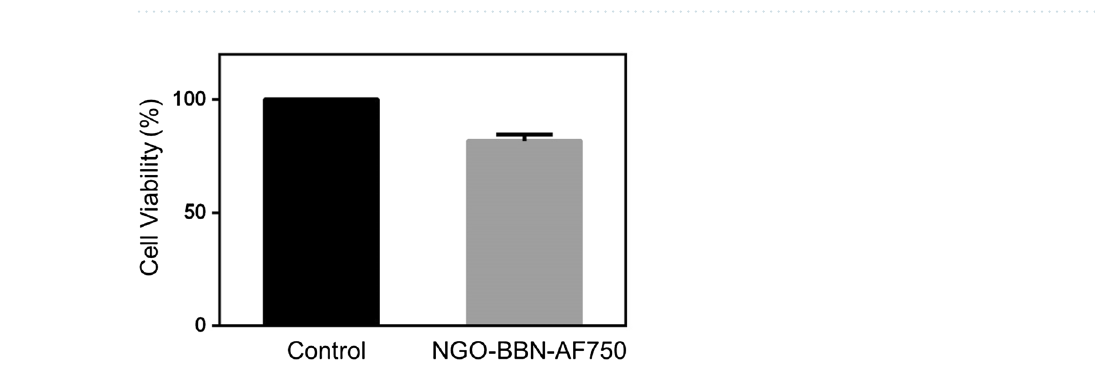
Figure 10. Cell viability treated without (control) and with